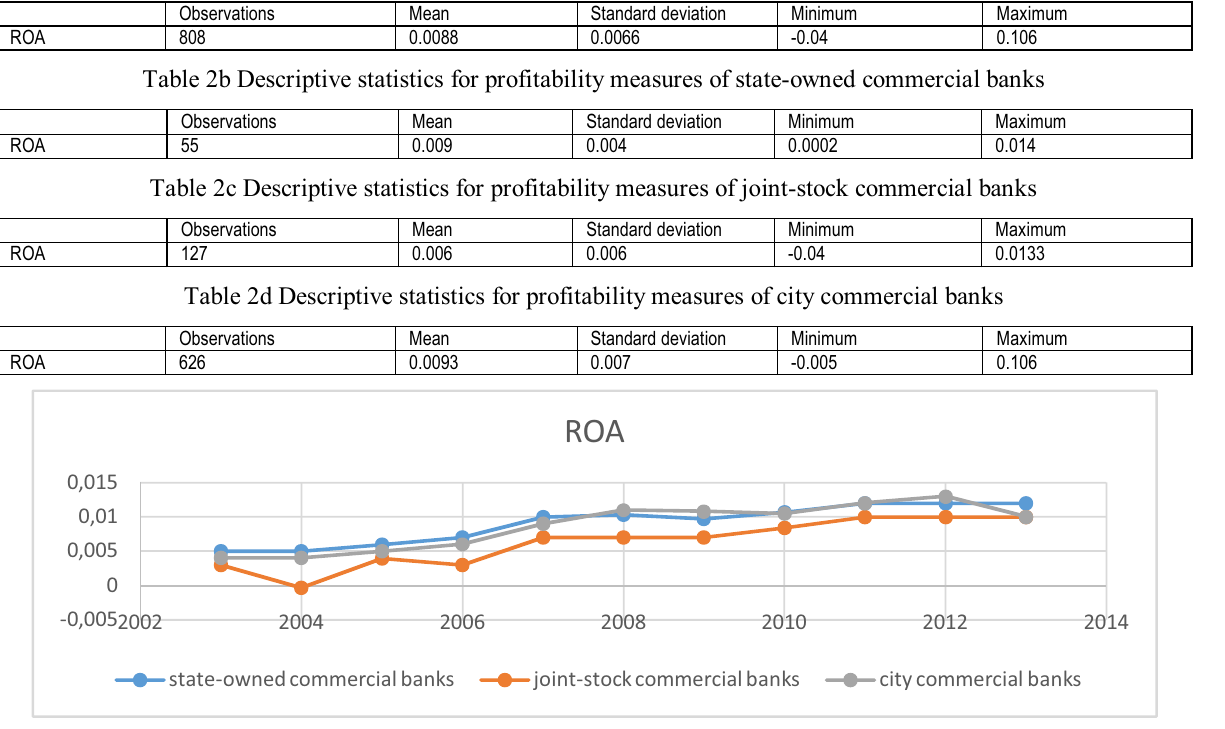
Table 2a Descriptive statistics for profitability measures of Chinese banking industry